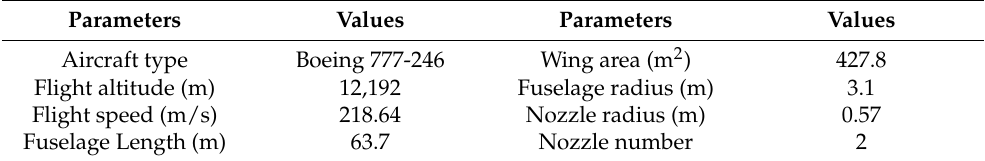
Table 2. Aircraft